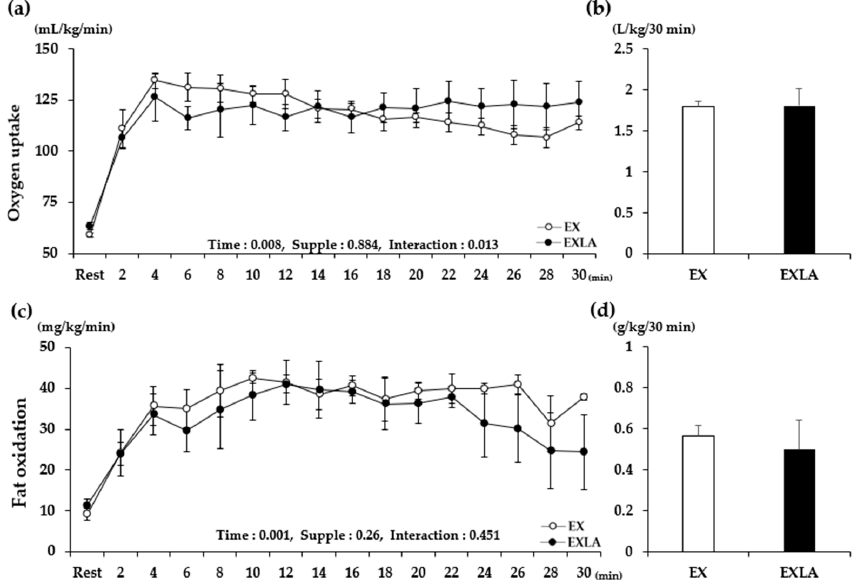
Figure 1. Changes in VO 2 and FO during exercise. ( a , c ) VO 2 and FO changes over time for 30 min, respectively; ( b , d ) total VO 2 and FO for 30 min, respectively. Supple, supplement effect; Inter, interaction effect; VO 2 , oxygen uptake; FO, fat oxidation; EX, exercise control group; EXLA, exercise with lactate intake group. Values represent the mean ± standard deviation ( n = 8).